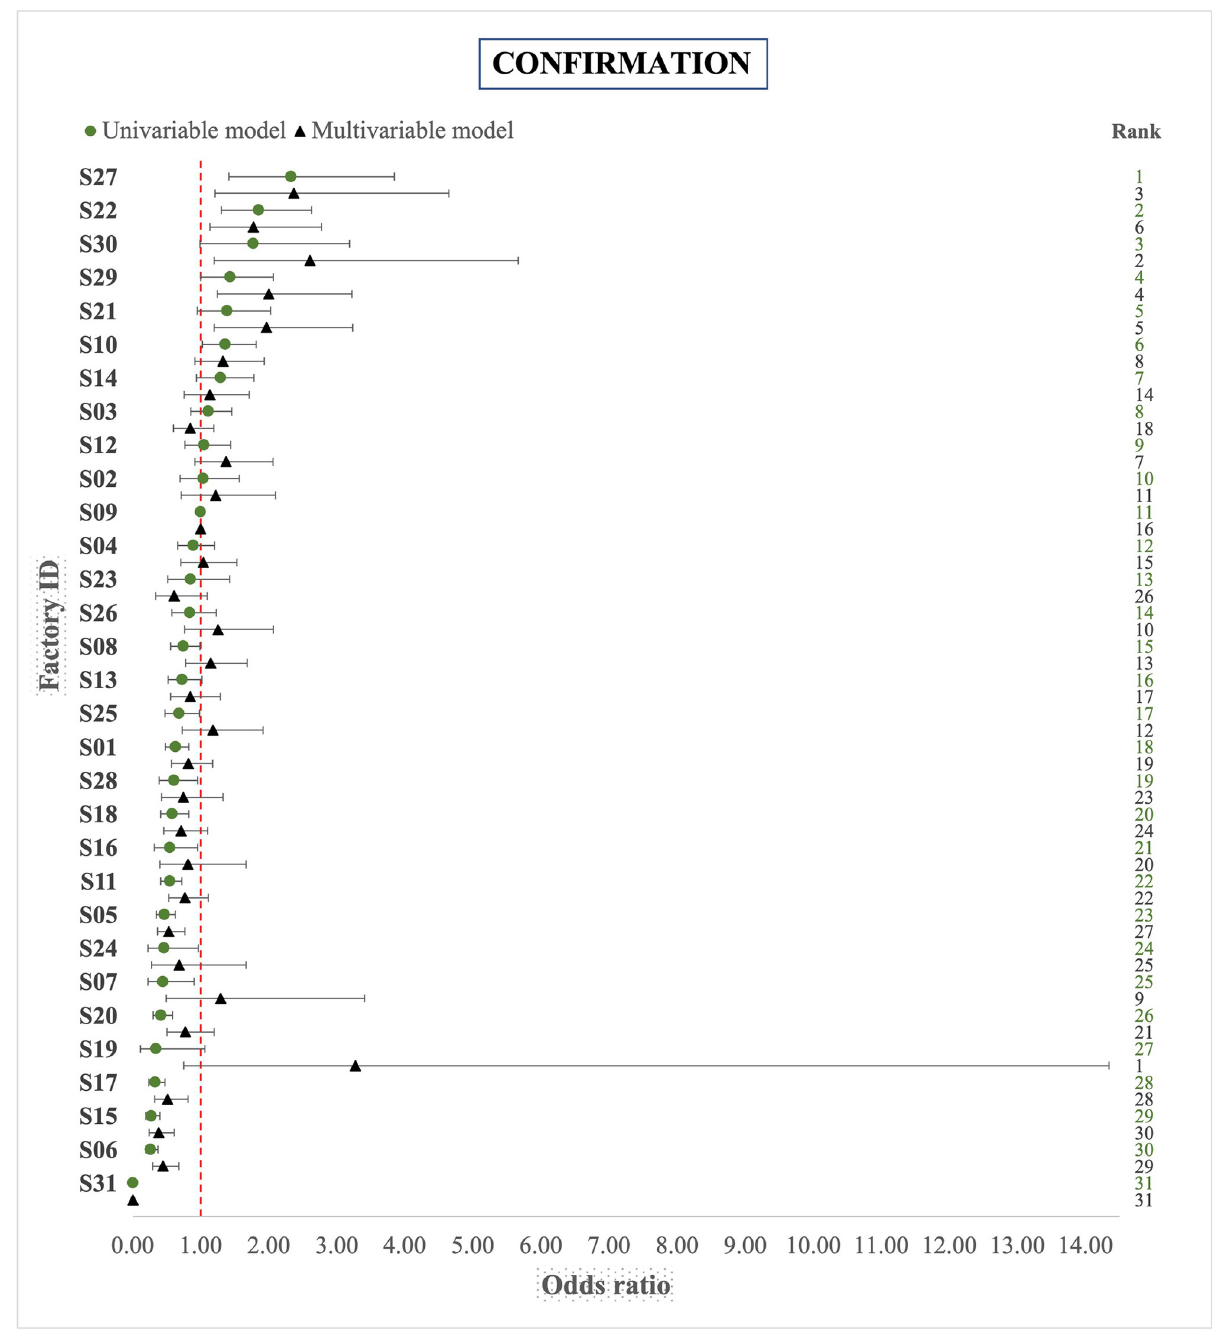
Fig 4. Comparison of factory ranking based on OR derived from univariable and multivariable (adjusted for covariates and random herd effect) logistic regression results of bTB confirmation of lesions submitted from animals slaughtered (n = 13,337) in Irish factories in the period 2014– 2018. S09 = reference